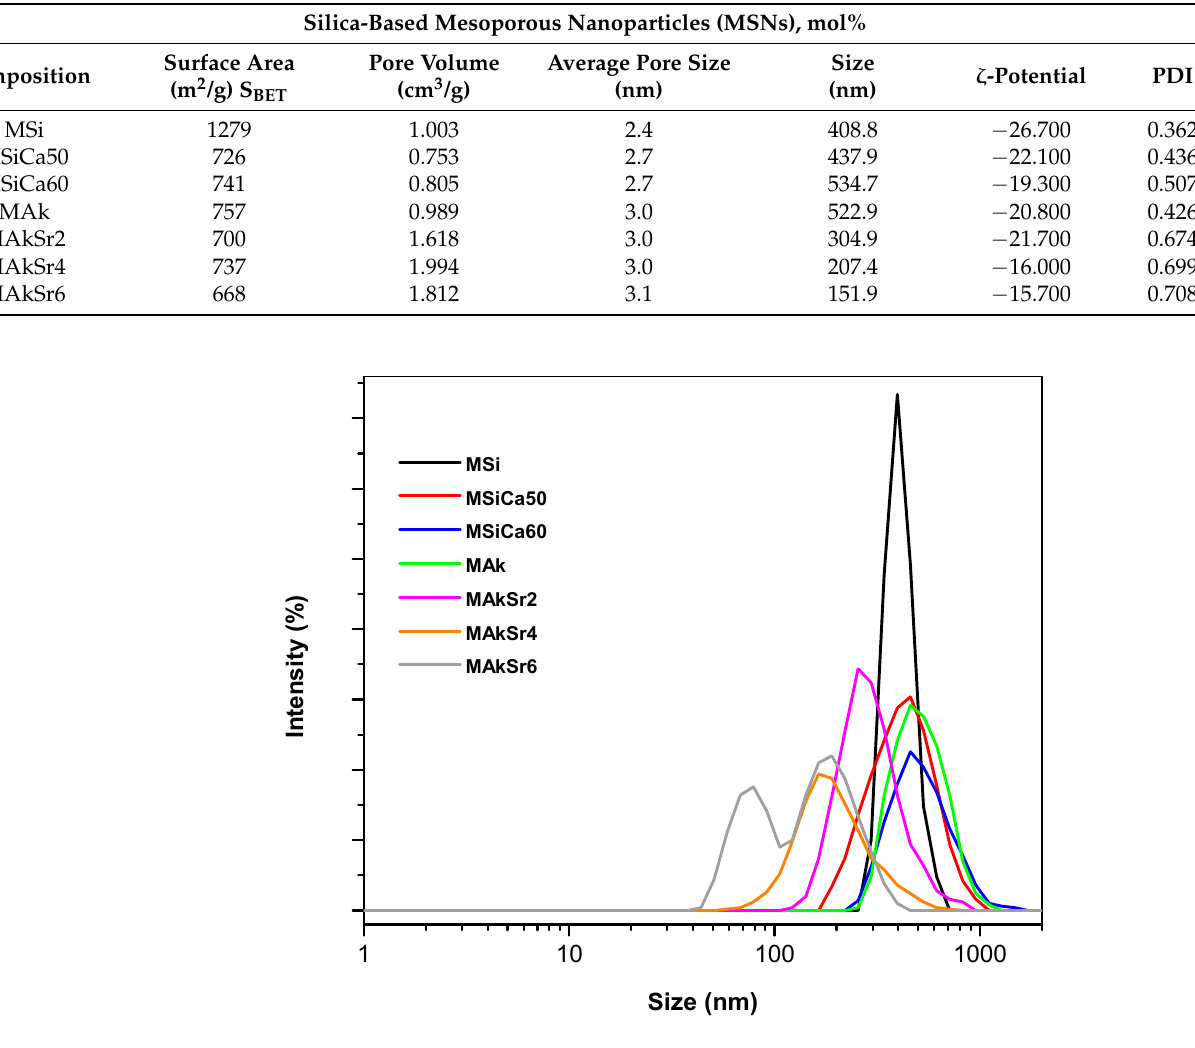
Figure 3. Size distribution of mesoporous silica-based nanoparticles (MSNs) measured by dynamic light scattering (DLS).